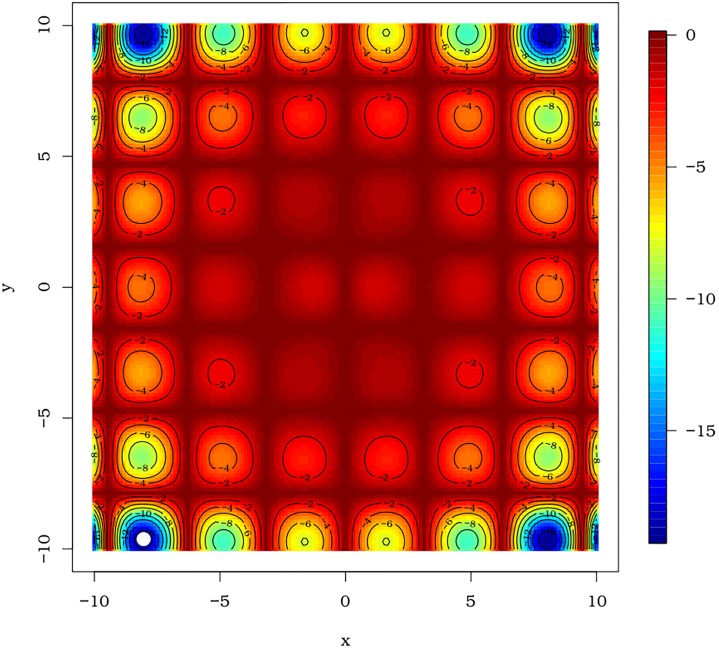
Levels of the Hölder function.The white point is the minimum value obtained by the pso() function.